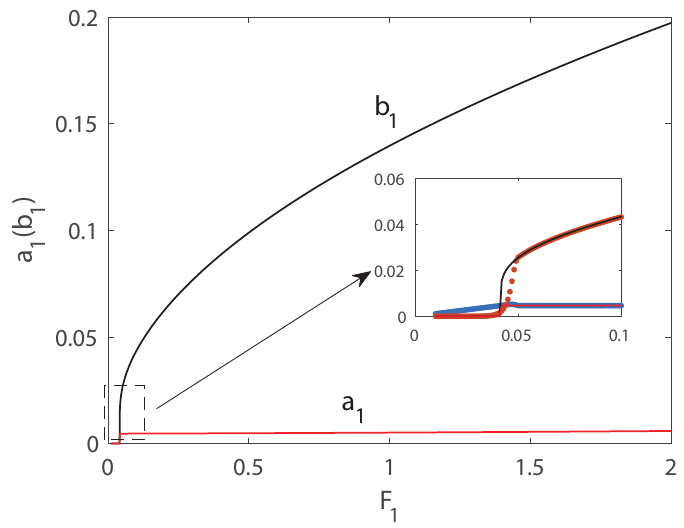
Figure 7. Amplitudes of response as functions of the excitation amplitude F 1 . Line: pseudo-arclength continuation method, Points: long-time-integration